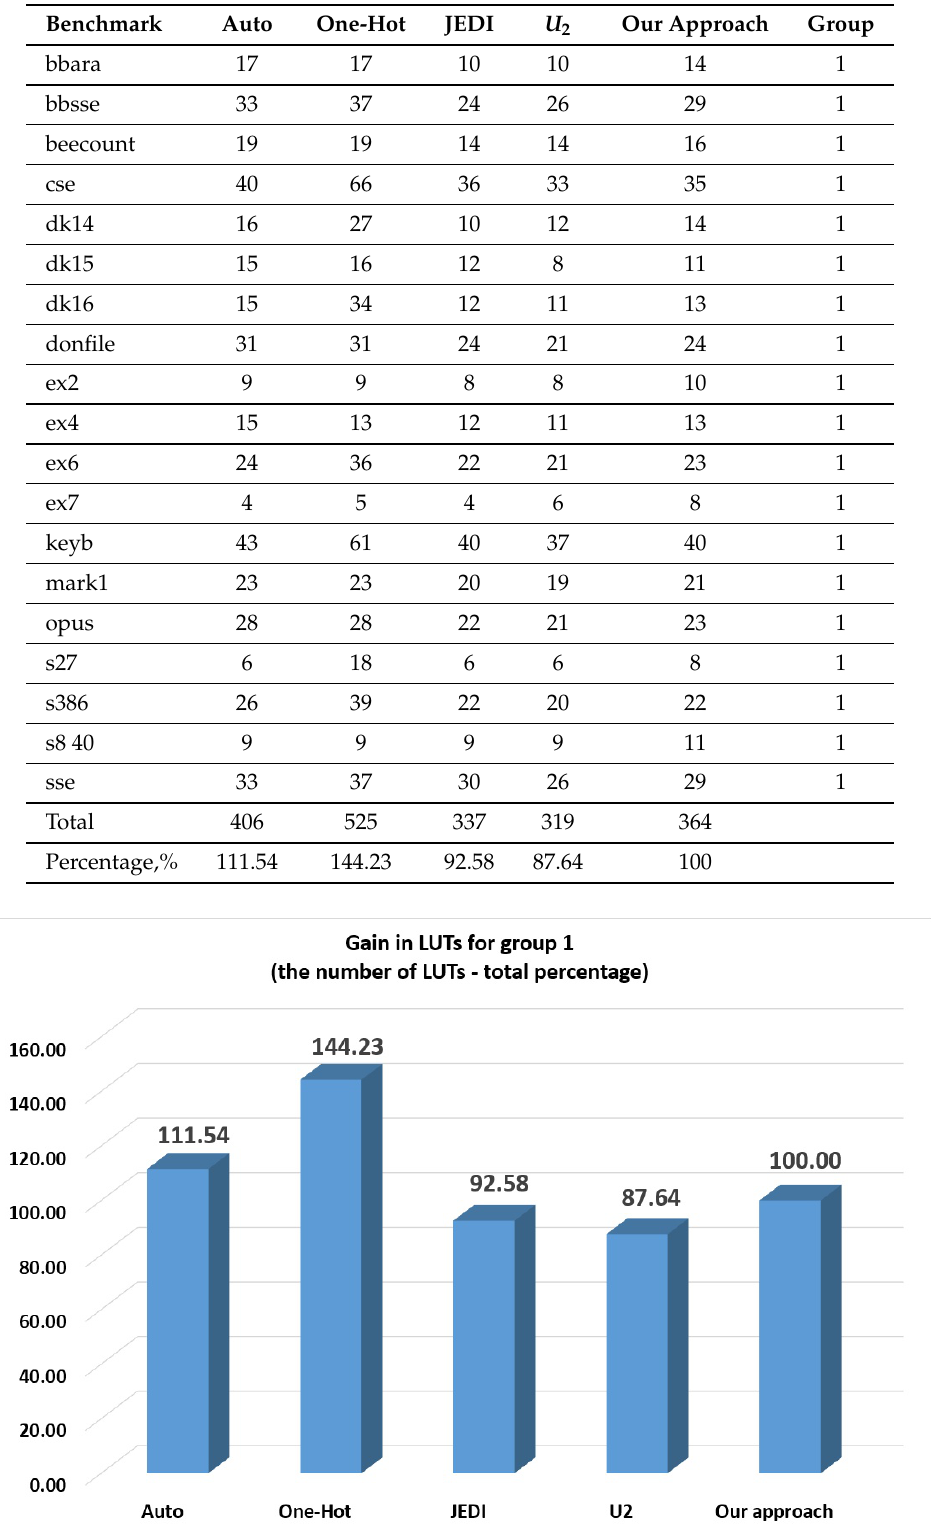
Table 10. Gain in LUTs for group 1 (LUT count).